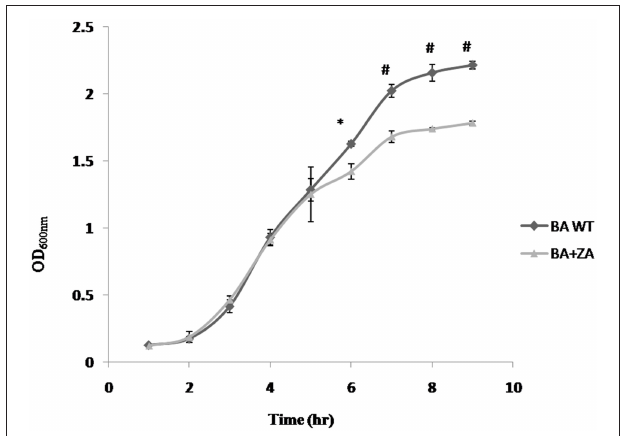
FIGURE 8 | Effect of ZA on growth of B. anthracis . Data is standard mean ± SME of three independent experiments. * indicate p ≤ 0.05 and # indicates p ≤ 0.001 .